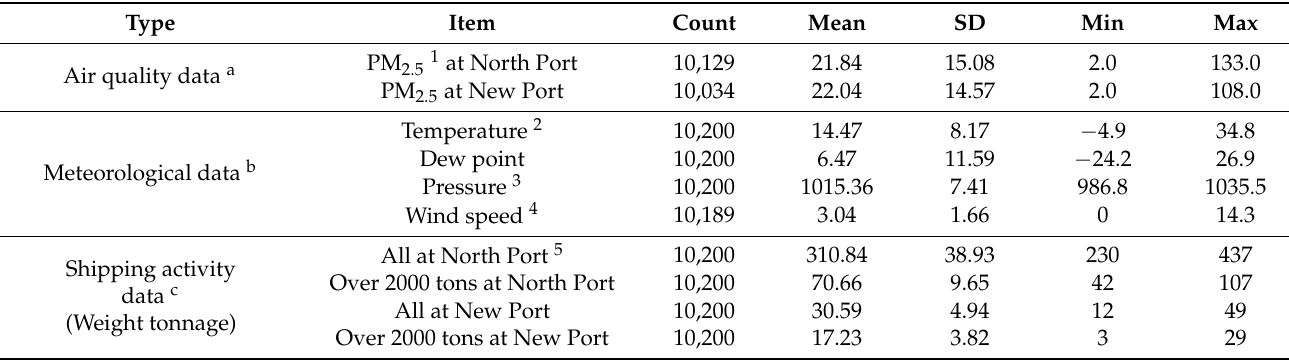
Table 2. Summary of the PM 2.5 , shipping activity, and meteorological data statistics (time period: 1 January 2019 to 29 February